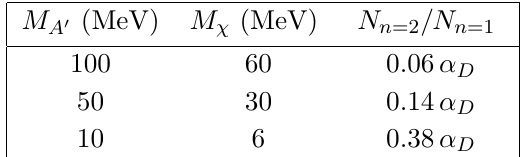
Table 3 . The number of events at MicroBooNE for double- A sion, for three sets of (cid:31) and A 0